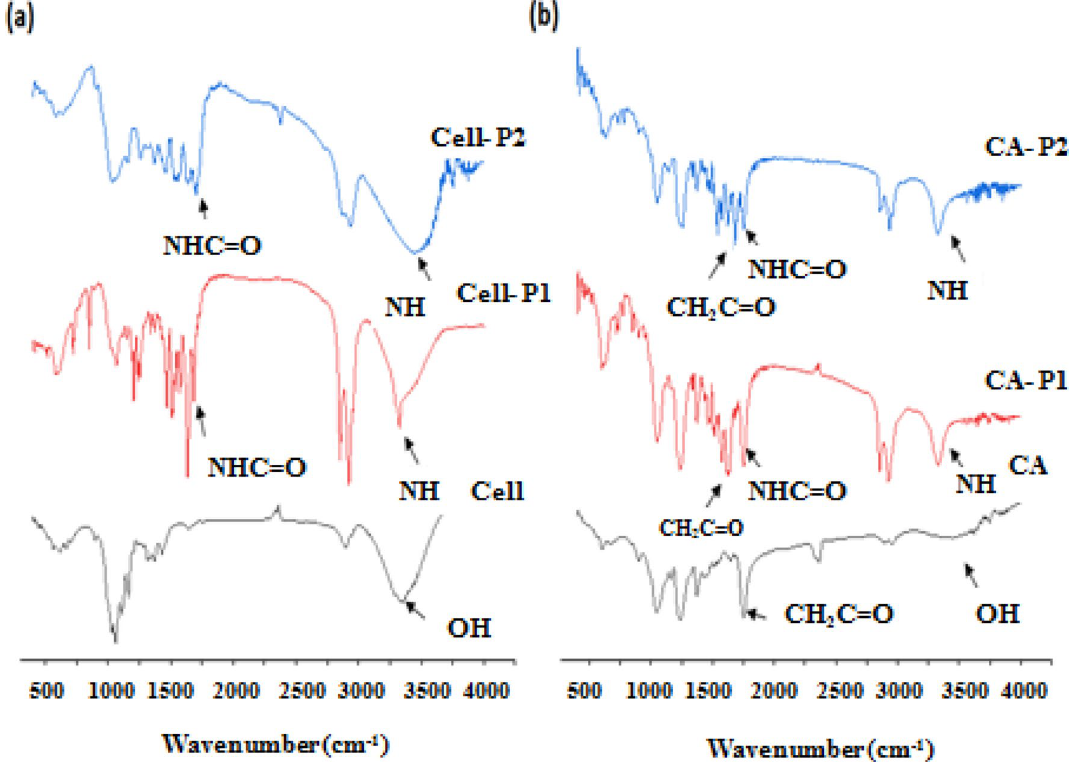
Figure 2. FT-IR spectra for: ( a ) cellulose, Cell-P 1 & Cell-P 2 ; and ( b ) CA, CA-P 1 , & CA-P 2